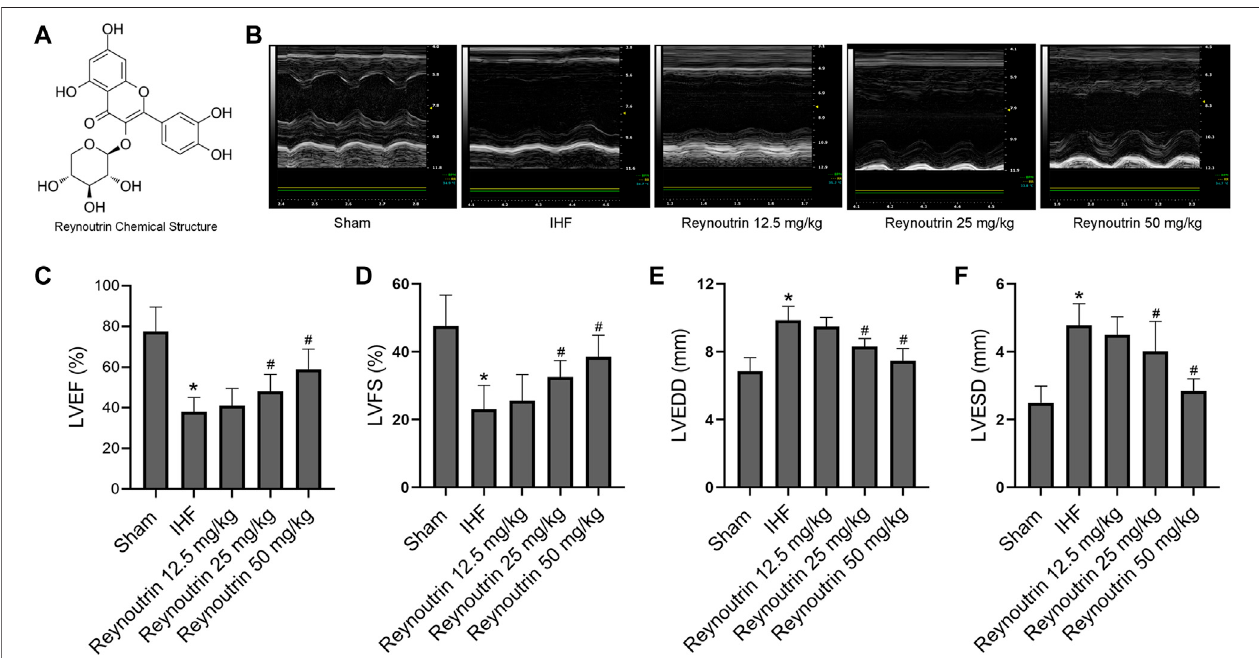
FIGURE 1 | Effects of reynoutrin on cardiac function of rats. (A) The chemical structure of reynoutrin (PubChem CID: 5320861). (B) The representative image of echocardiogram in each group. (C) LVEF histogram of each experimental group. (D) LVFS histogram of each experimental group. (E) LVEDD histogram of each experimentalgroup. (F) LVESDhistogramofeachexperimentalgroup.Thevalueswerepresentedasthemeans ± standarderrorineachexperimentgroup(n (cid:1) 10).* p < 0.05 vs. Sham group; # p < 0.05 vs. IHF group.